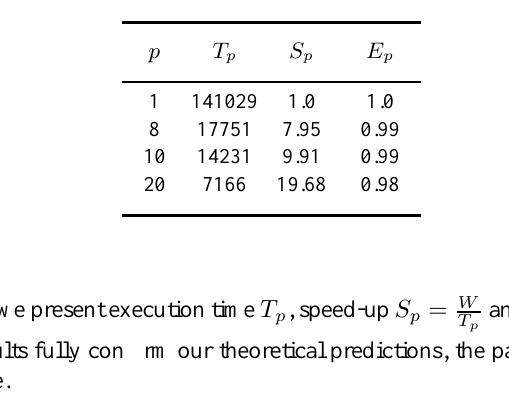
Table 3. Execution time, speed–up and efficiency of the parallel